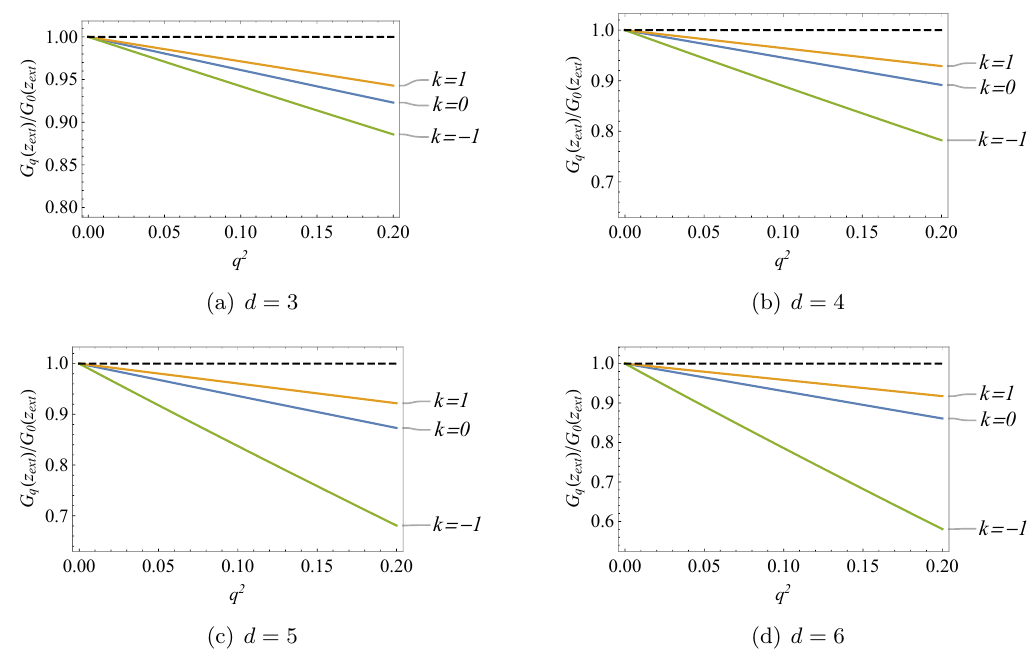
Figure 9 . For the case of ‘ AdS = 1 and fixed entropy density S = 1 G q ( z ext ) /G 0 ( z ext ) , where G 0 ( z ext ) is the maximum growth rate of vacuum case. The horizontal axis represents the charge parameter q 2